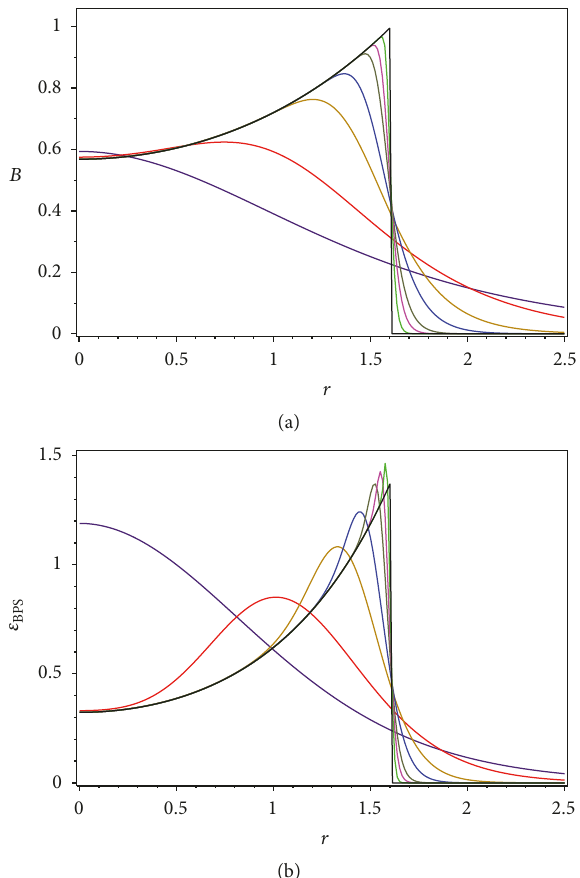
Figure 9: The magnetic field 𝐵(𝑟) (a) and the BPS energy density 𝜀 BPS (𝑟) (b) come from generalized Maxwell-Chern-Simons-Higgs model (93) with 𝐺(𝑔) = 1 and 𝜔(𝑔) = 𝜆𝑔 2𝜆−2 . Observe that 𝜆 = 1 (indigo lines) represents the usual MCSH model and the true compacton solution is given by 𝜆 = ∞ (black lines). The convention for the color of the lines is the same given in Figure